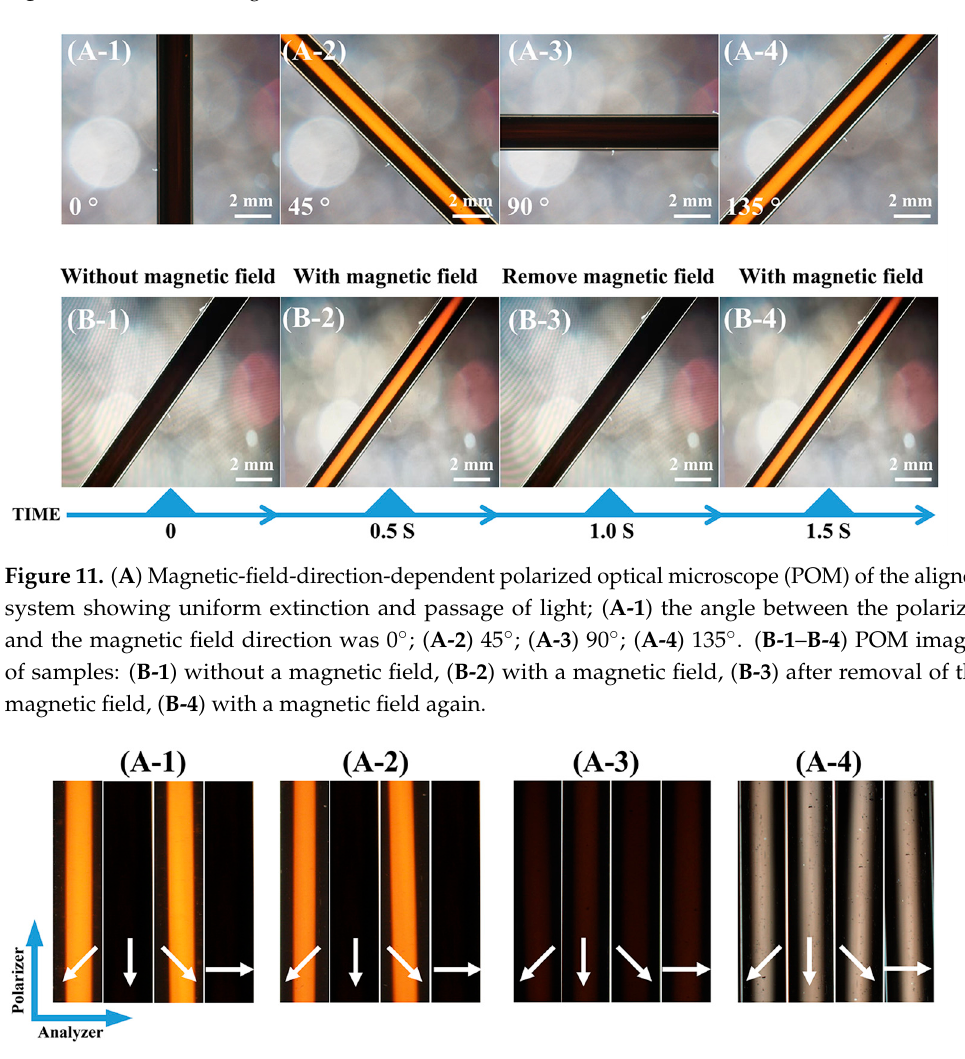
Figure 12. POM images of the GO@Fe 3 O 4 sol in various pH conditions and GO aqueous solution under the magnetic field in various directions (the white arrows indicate the magnetic field direction). ( A-1 ) GO@Fe 3 O 4 -pH = 1.0, ( A-2 ) GO@Fe 3 O 4 -pH = 1.5, ( A-3 ) GO@Fe 3 O 4 -pH = 7.0, ( A-4 ) GO-pH = 7.0.